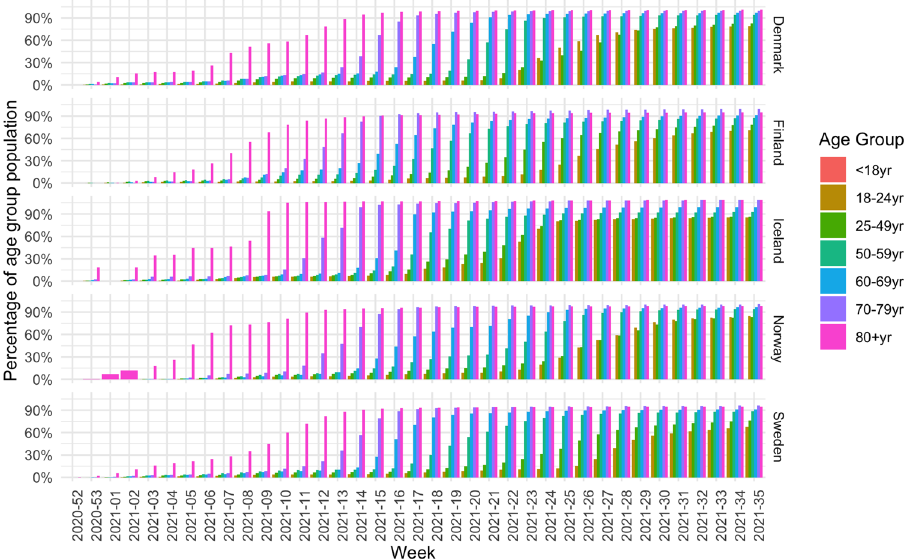
Figure 5. Fraction of population of each age group that has received the first vaccine dose.